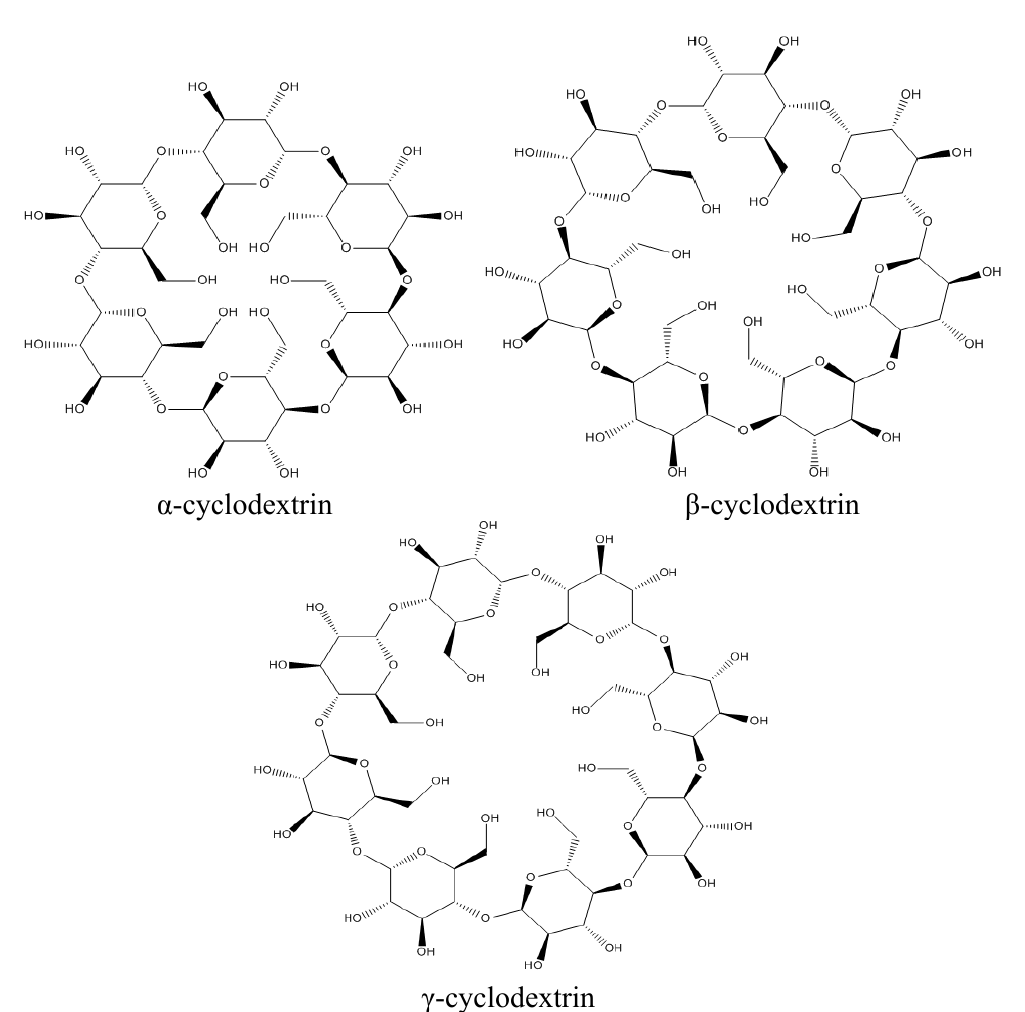
Figure 1. The chemical structures of cyclodextrins ( α , β , γ ).